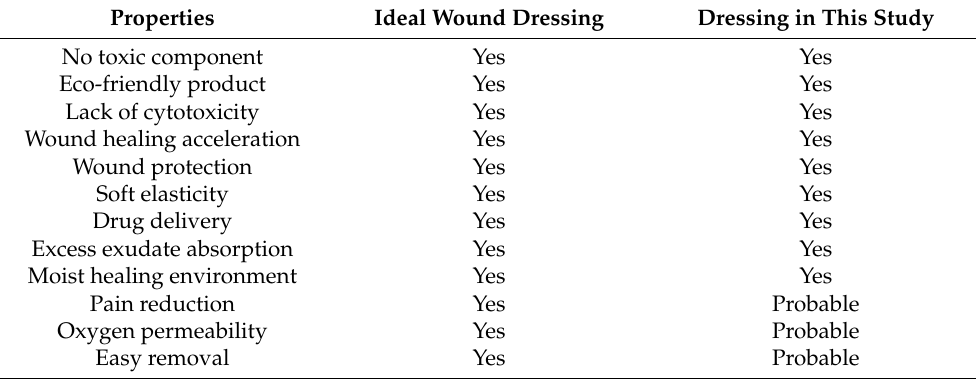
Table 2. Comparing properties of the dressing in this study to the ideal hydrogel wound dressing